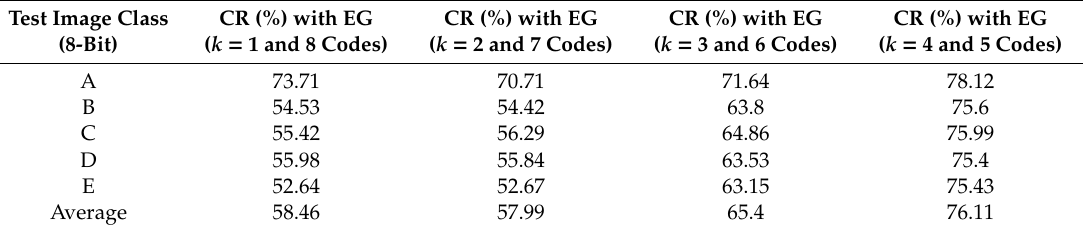
Table 8. CR comparison with EG with di ff erent codewords for 8-bit images.